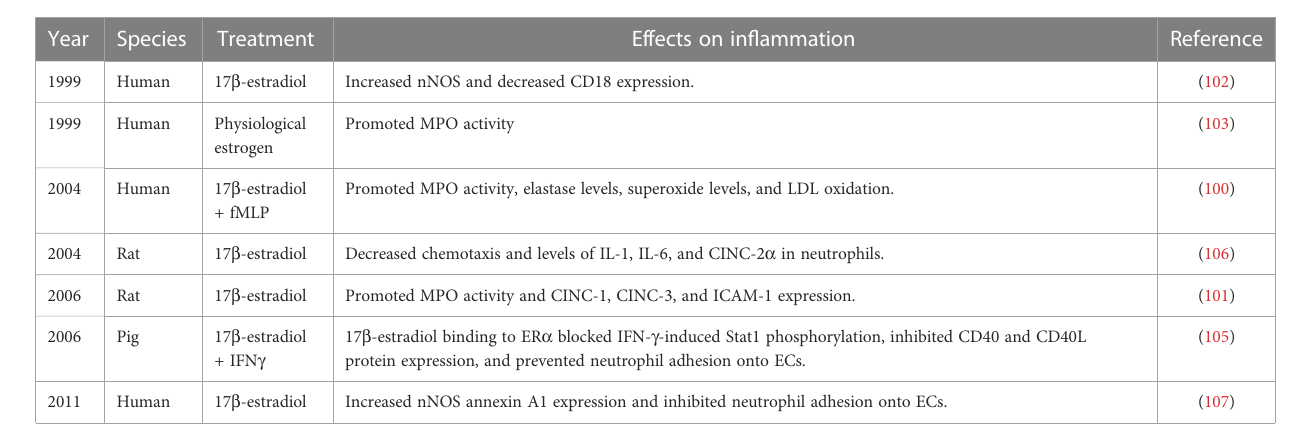
TABLE 4 Anti-in fl ammatory effects of estrogen on